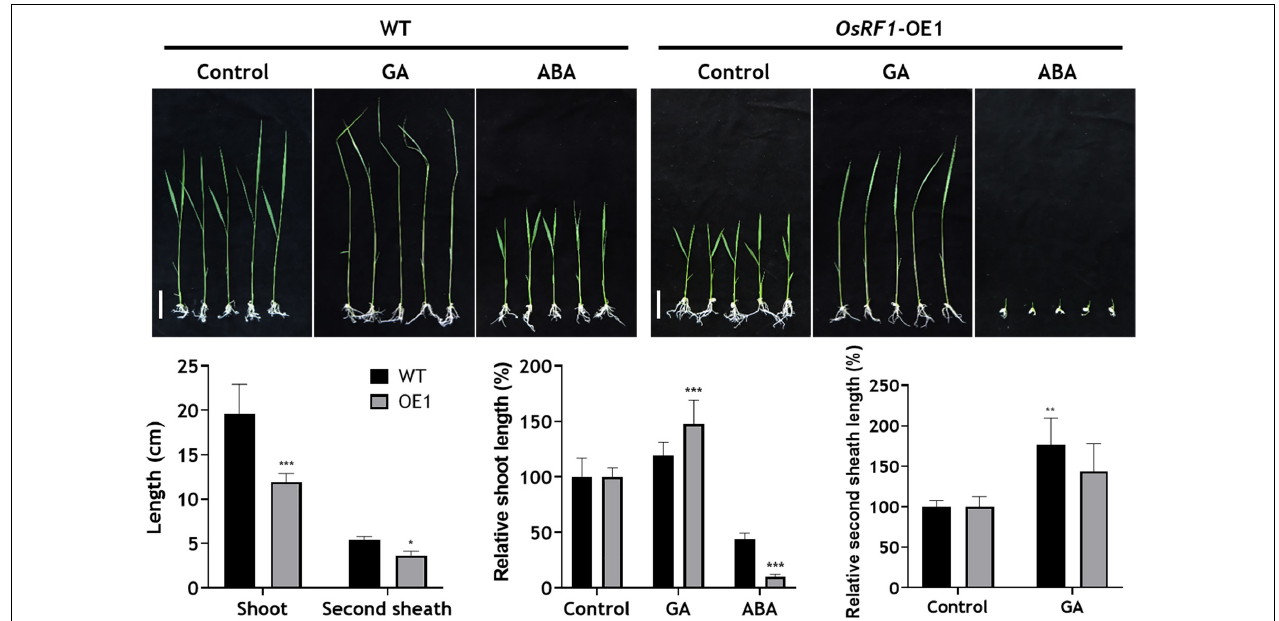
FIGURE 3 | Overexpression of OsRF1 leads to enhanced sensitivity to ABA-mediated inhibition of shoot elongation. WT and OsRF1 -OE rice were germinated in distilled water for 3 days and transplanted to 1/2 MS media containing 1 µ M GA 3 or 3 µ M ABA. The total shoot length and second internode length of rice seedlings were measured after 7–10 days. Bar = 2 cm. Data represent the mean ( ± SD) from three biological replicates ( n = 25 for each line). All statistical analyses for data were performed by Student’s t -test. * P < 0.05; ** P < 0.01; *** P <